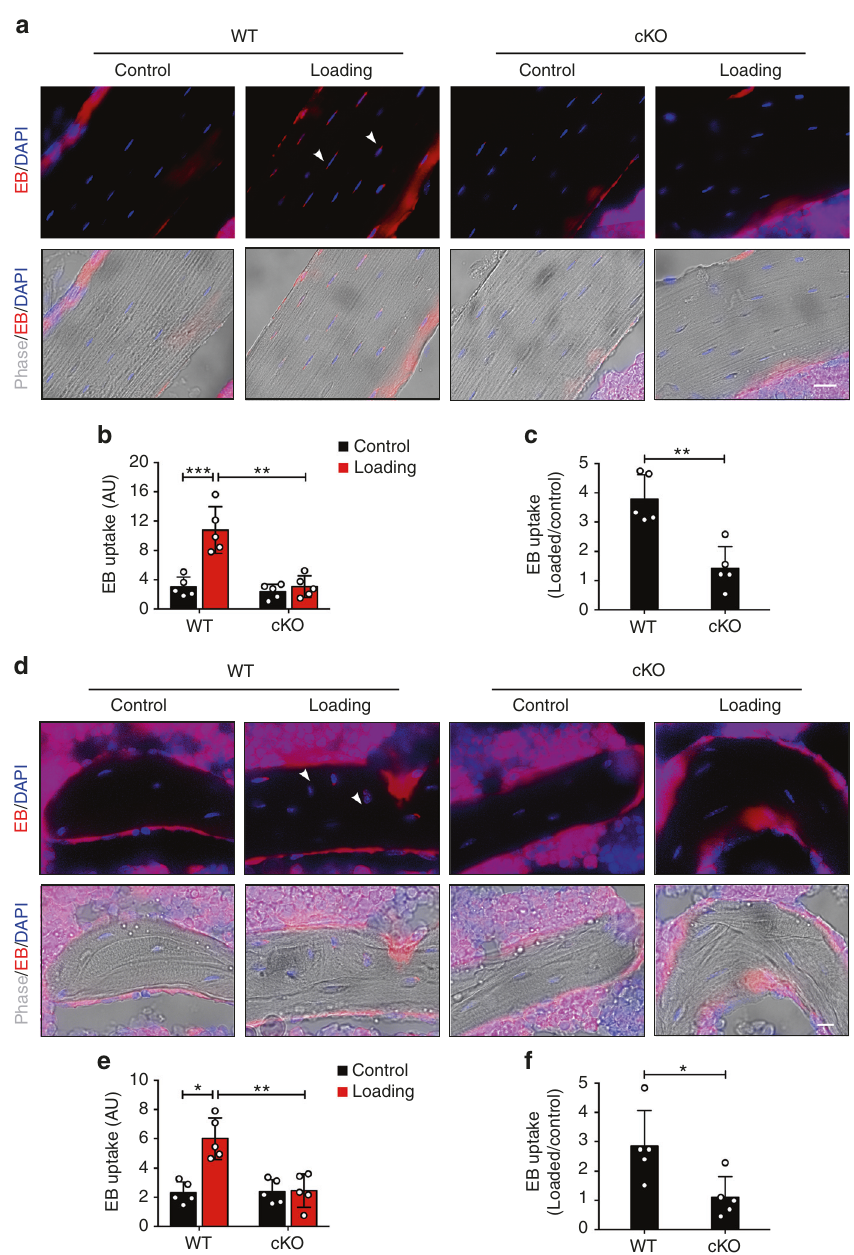
Fig. 6 Hemichannel opening in osteocytes induced by mechanical loading was inhibited in integrin α 5 cKO. a Representative fl uorescence images of EB dye uptake in diaphyseal 37% cortical VOI, for both loaded and contralateral, unloaded tibias of WT and cKO mice. The white arrowheads indicated the EB-positive osteocytes. Scale bar, 20 μ m. b Quantitation of EB fl uorescence intensity in osteocytes in cortical bone for both loaded and contralateral, unloaded tibias of WT and cKO mice. c EB fl uorescence intensity is presented as a fold increase relative to non-loaded groups. n = 5 per group. d Representative images of EB dye uptake in metaphyseal trabecular bone for both loaded and contralateral, unloaded tibias of WT and cKO mice. The white arrowheads indicated the EB-positive osteocytes. Scale bar, 10 μ m. e Quanti fi cation of EB fl uorescence intensity in osteocytes in metaphyseal trabecular bone for both loaded and contralateral, unloaded tibias of WT and cKO mice. f EB fl uorescence intensity is presented as a fold increase relative to non-loaded groups. n = 5 per group. Mean ± SD. * P < 0.05; ** P < 0.01; *** P < 0.001. Paired t test was performed for loaded and contralateral tibias and unpaired t test was performed for loaded or control tibias between WT and cKO